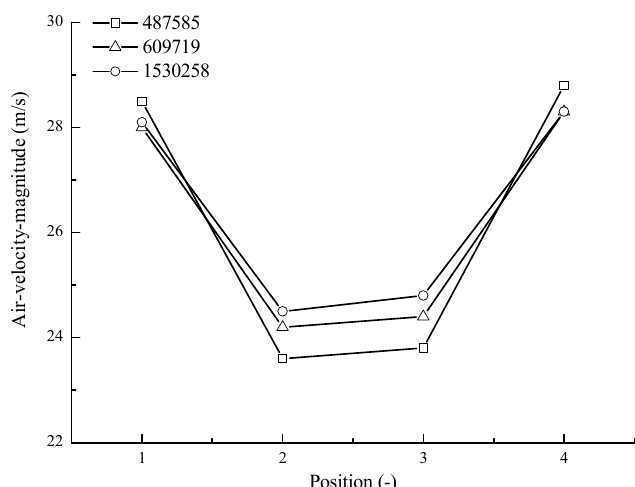
Figure 3. Verification of grid independence, the number of meshes is 487,585, 609,719, and 1,530,258, respectively, when air inflow is 12 g/s, the air phase velocities at four positions (−0.11,0,0), (−0.09,0,0), (0.09,0,0), and (0.11,0,0) in z = 0 plane.